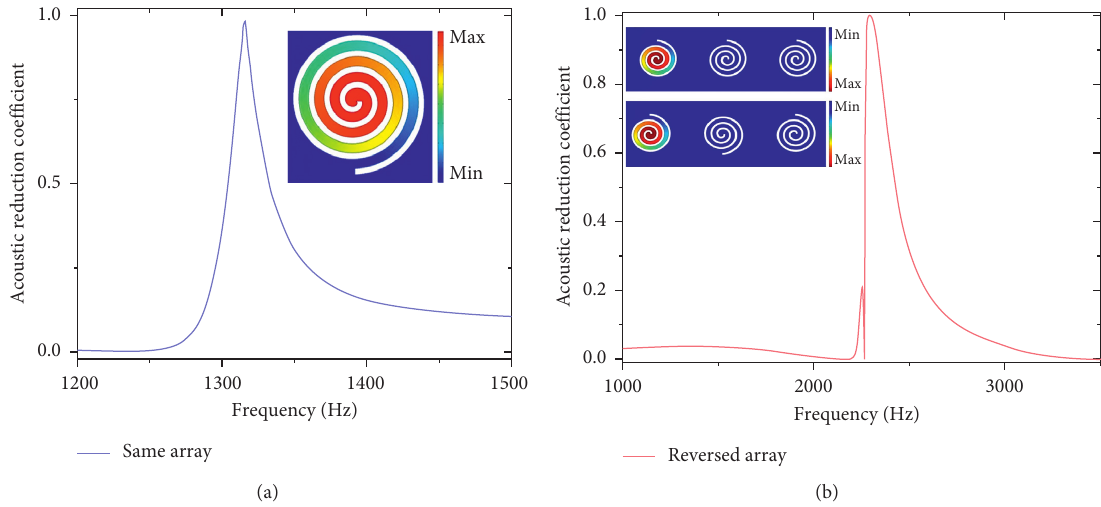
Figure 2: (a) The acoustic reduction coefficient for the rectangular channel with one Archimedean spiral unit. The inset shows the acoustic pressure distribution in the peak frequency. (b) The comparison of the same spiral unit array and the middle-reversed array for the acoustic reduction coefficient. The insets show the corresponding acoustic pressure distributions in peak